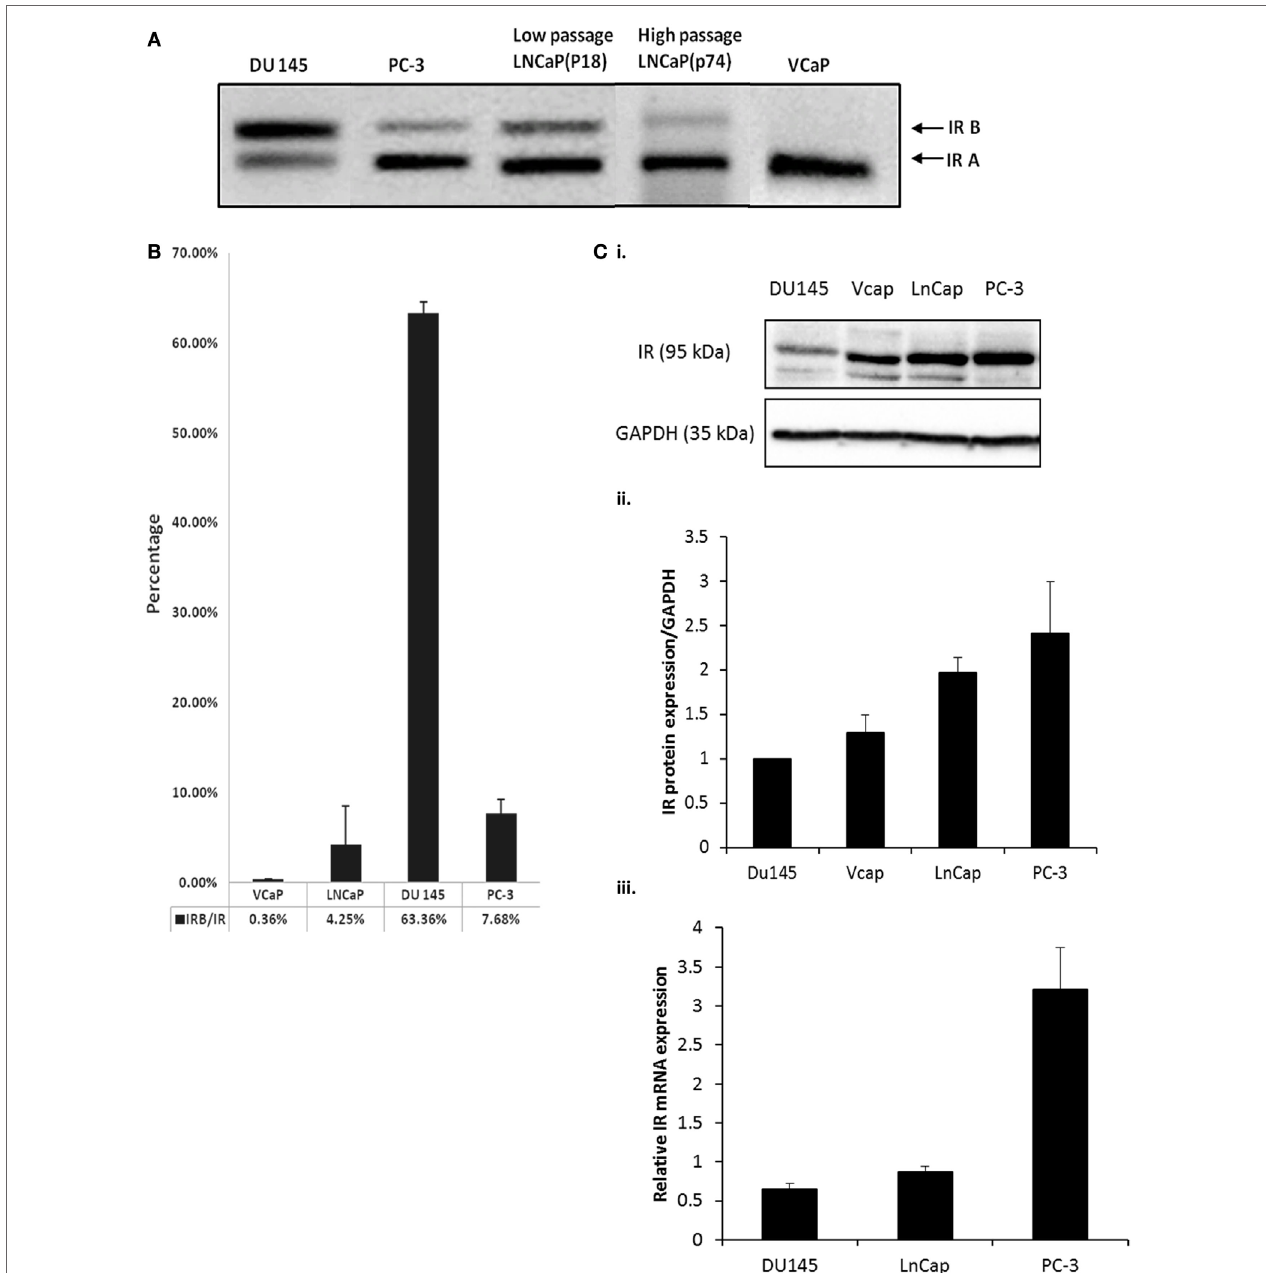
FigUre 1 | (a) DU145, PC-3, LNCaP (low passage P18 and high passage P74) and VCaP cells were cultured in GM for 72 h followed by RNA extraction and IR-A and IR-B assessment detected by RT-PCR. The size of IR-B and IR-A were 171bp and 135bp, respectively. (B) q-PCR was used to detect the percentage of IR-B expression compared to total IR expression in different cell lines. IR-B, IR, and reference gene 18s primer pairs were used to amplify the signal of each target gene. The graph shows the percentage of IR-B compared to IR: the error bars represent the SE of the mean of the repeats and each experiment was performed in triplicate ( n = 3). (c) (i) Western immunoblot of whole cell lysates extracted from DU145, PC-3, LNCaP, and VCaP cells after the cells had reached a confluence of 80% in GM to show the abundance of the IR relative to GAPDH used as a loading control. This is representative of blots performed at least three times. The optical density measurements showing the mean of the three repeats are shown in (c) (ii) . (c) (iii) shows q-PCR of mRNA levels for the IR in DU145, LNCaP, and PC3 cells ( n = 3).